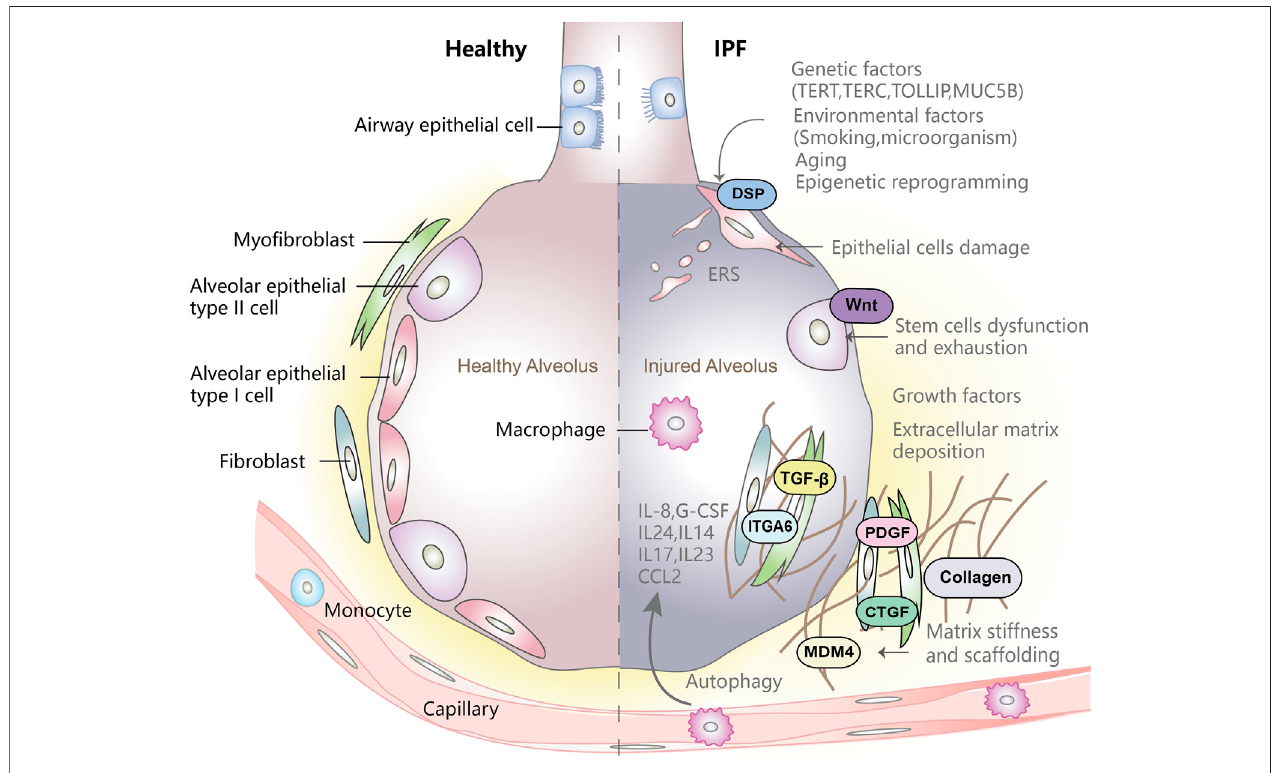
FIGURE1| Pathogenesisofidiopathicpulmonary fi brosis.Geneticfactorsaffecttheintegrityofepithelialcells,environmentalfactorsandaging-relatedchangeswill trigger epigenetic reprogramming. The combined action of the three factors will cause epithelial cell damage and trigger the abnormal activation of epithelial cells. Activated epithelial cells secretes a large number of cytokines such as TGF- β which consequently promotes fi broblast migration and proliferation, and also promote fi broblasts to differentiate into myo fi broblasts. Myo fi broblasts secrete large amounts of ECM, leading to ECM deposition. In addition, epithelial cell damage, disfunction and exhaustion of stem cells, abnormal deposition of extracellular matrix and matrix stiffness play a vital role in progression of abnormal lung fi brosis and remodeling of lung structure.